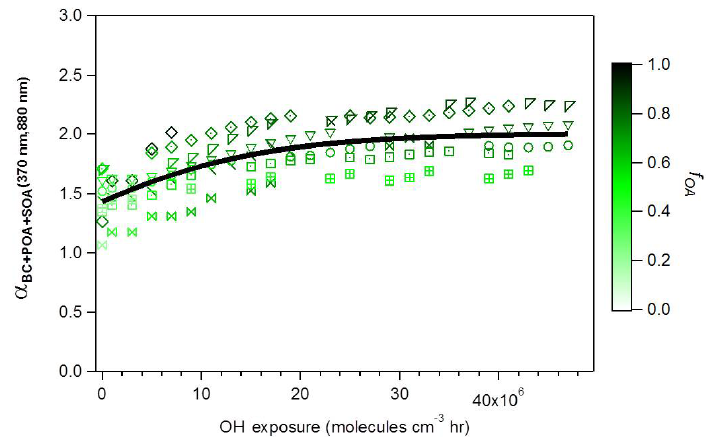
Figure 2. Evolution during photochemical aging of α BC + POA + SOA (370nm, 880nm) (two-wavelength Ångström exponent calculated using total absorption data at 370 and 880nm), where the different symbols denote individual experiments. Data are colored by the OA mass fraction f OA = M OA /(M OA + M BC ) . The black line is a fit to guide the